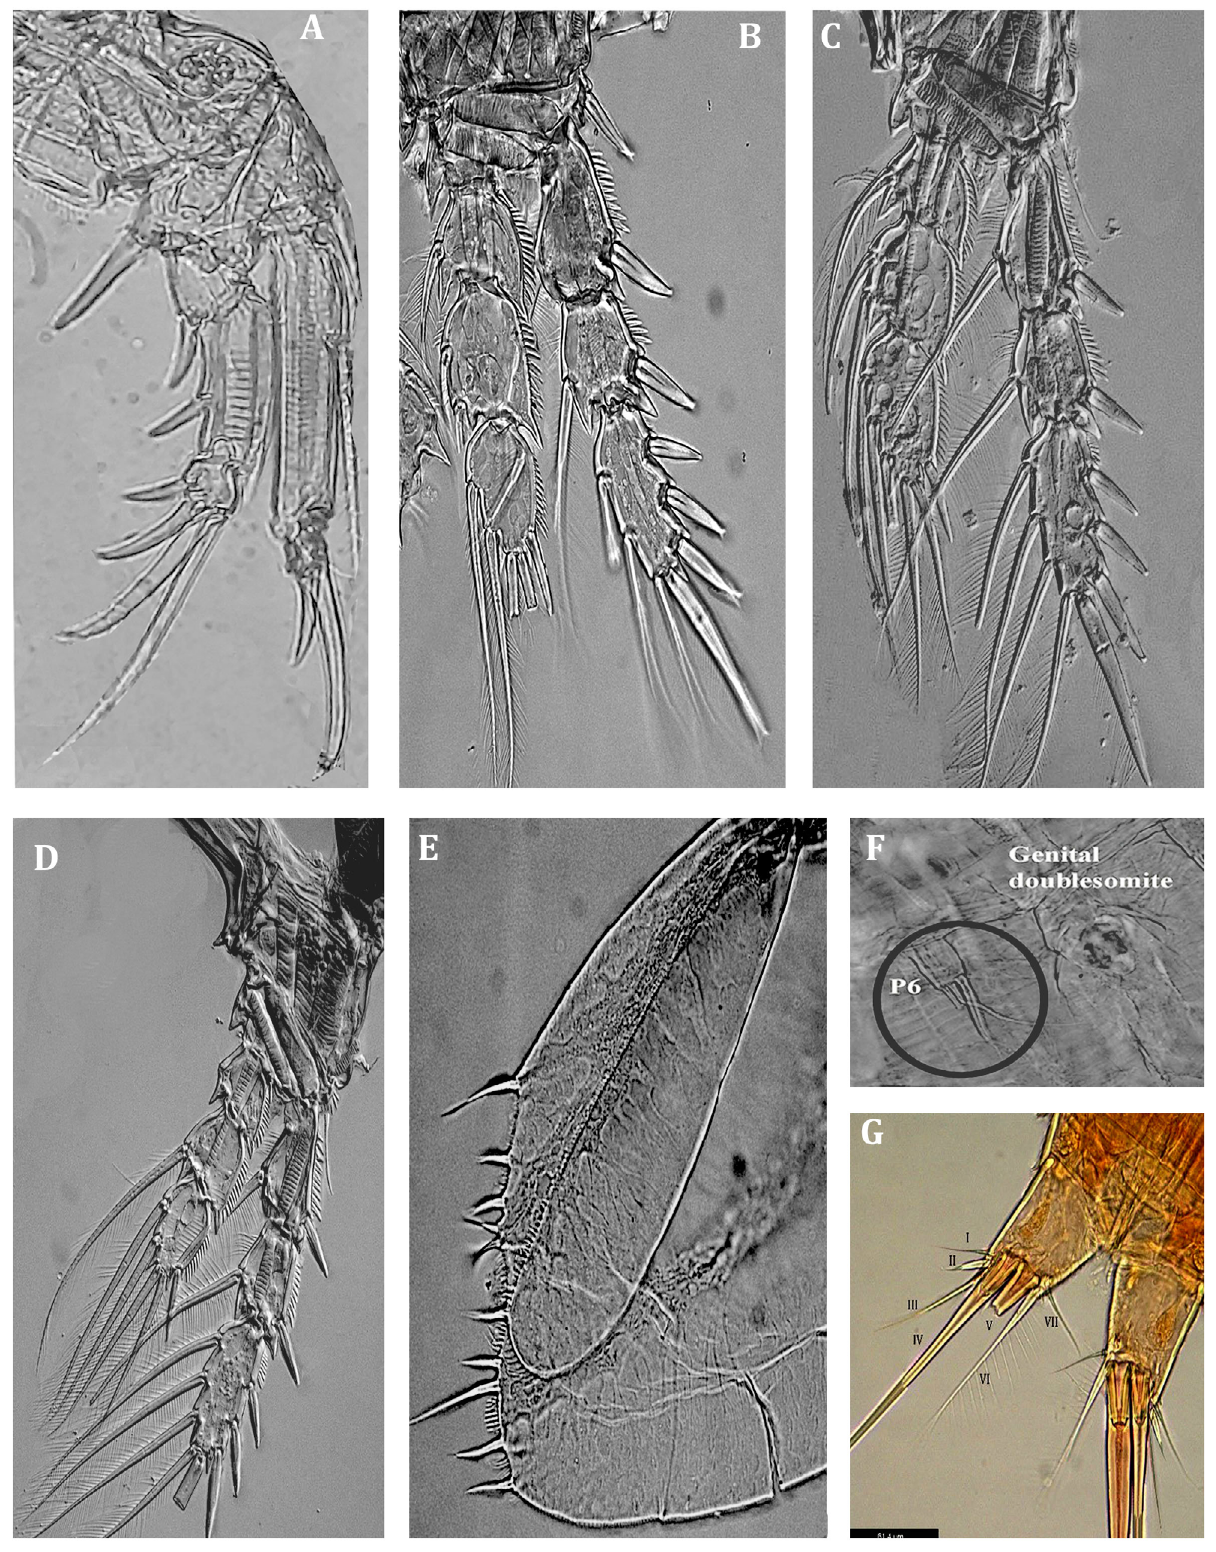
Figure 8. Eudactylopus fasciatus Sewell, 1940, female. A, P1; B, P2; C, P3; D, P4; E, P5; F, P6; G, caudal rami. Scale bars: 100